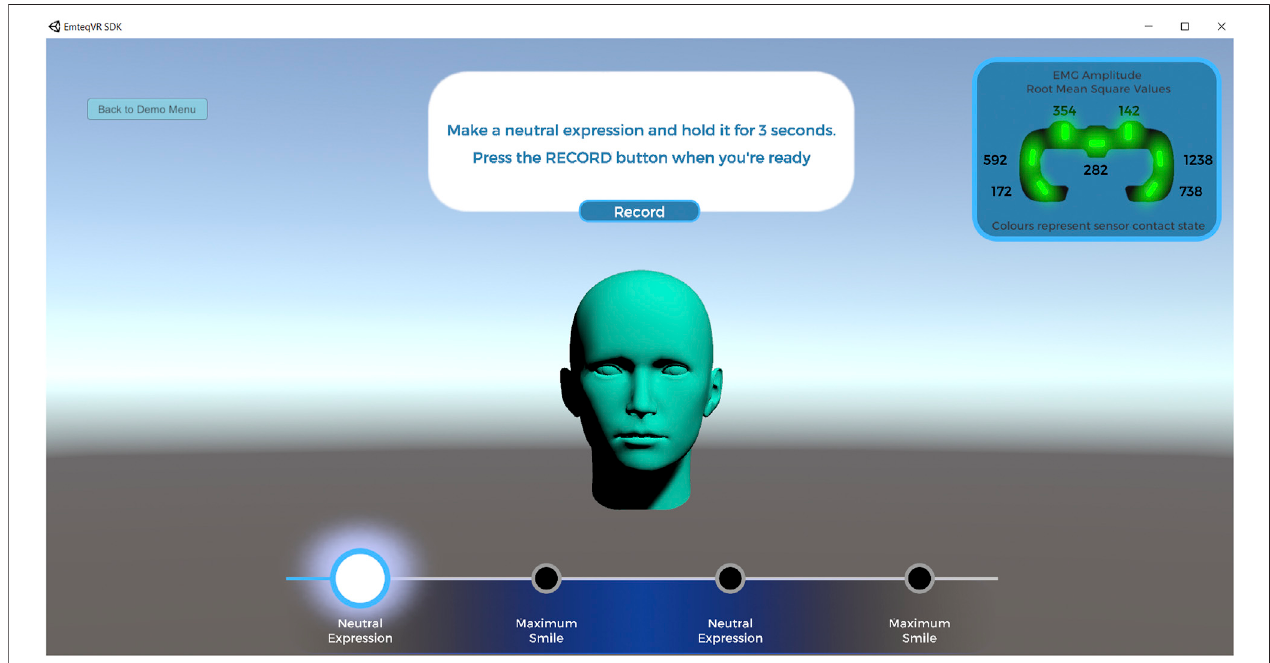
FIGURE 10 | emteqPRO Unity demo SDK calibration scene where users are asked to repeat neutral and maximum smile expressions.